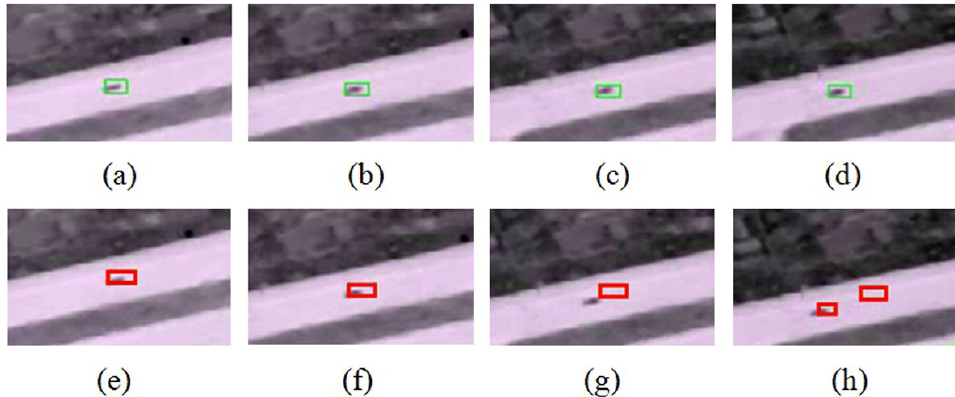
Figure 9. Comparison of results of target tracking by MSDU and MS for Sequence B. Green rectangles are used in parts ( a – d ) respectively to represent the results obtained using MSDU in the 30th, 60th, 90th and 120th frames; red rectangles are used in parts ( e – h ) to represent the corresponding results obtained using MS.